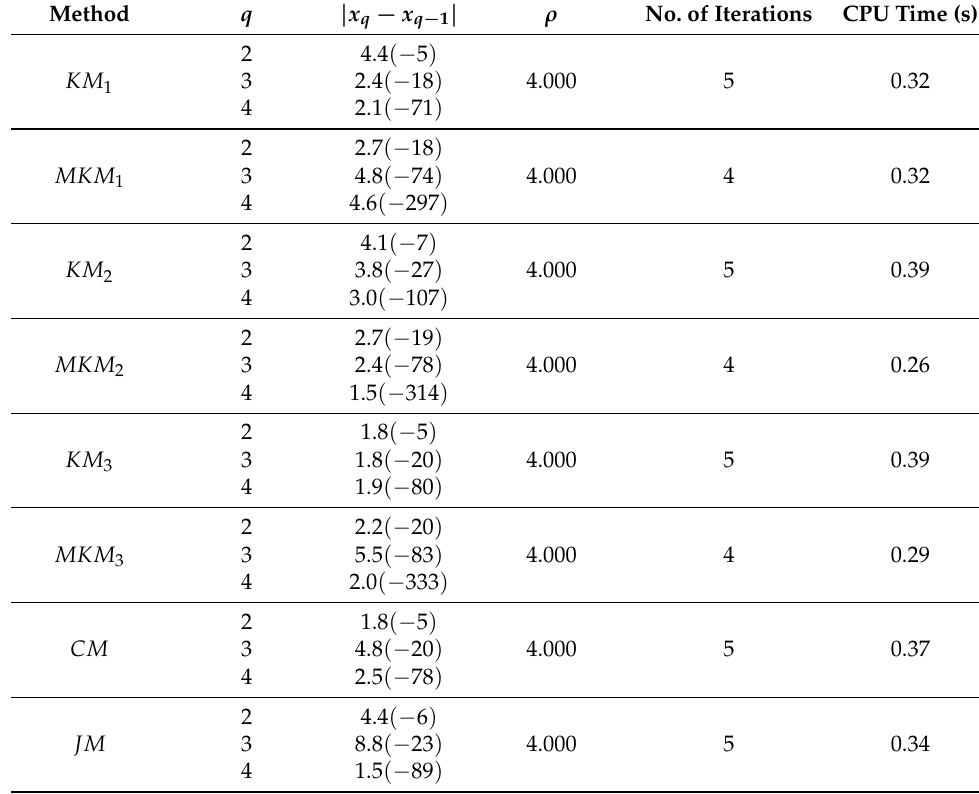
Table 1. Results of population growth model with initial guess x 0 =